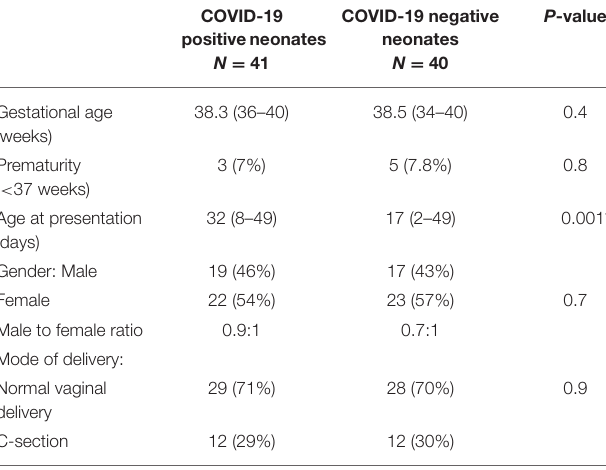
TABLE 1 | Demographic data for both